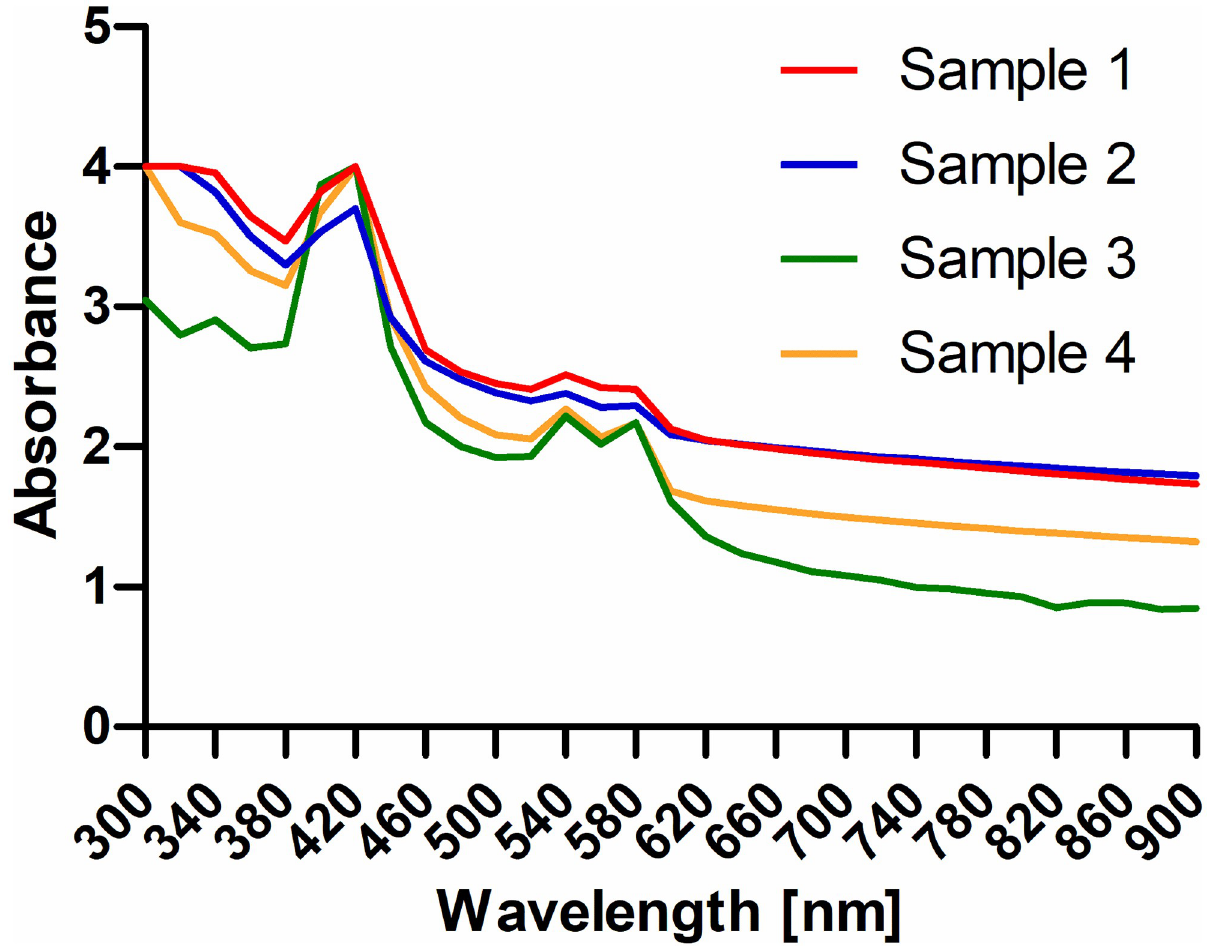
Fig 9. Area scan of four human TM samples. Absorbance was measured at the spot of least absorption at wavelengths between 300 nm and 900 nm.